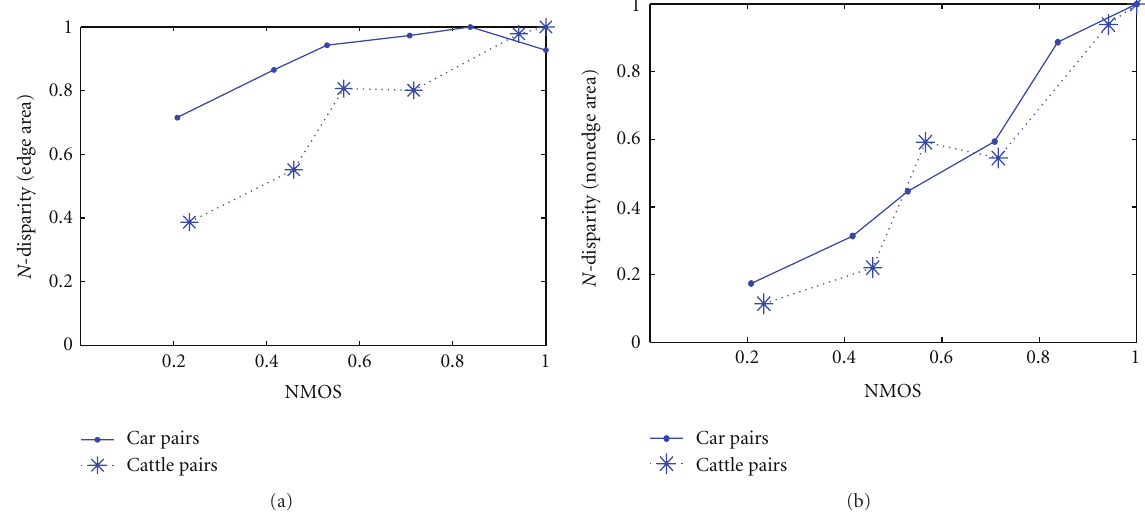
Figure 11: Normalized MOS versus Disparity for edge and nonedge areas of di ff erent Car and Cattle image pairs: (a) NMOS versus N - Disparity (edge areas, AZC e ) (b) NMOS versus N -Disparity (nonedge areas, AZC n ).